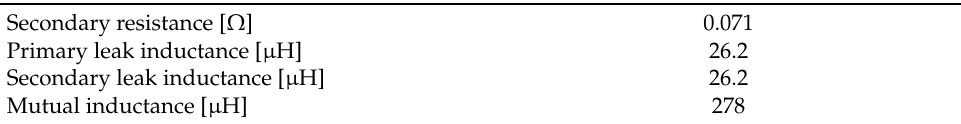
Table 5. Machine parameters of IM.